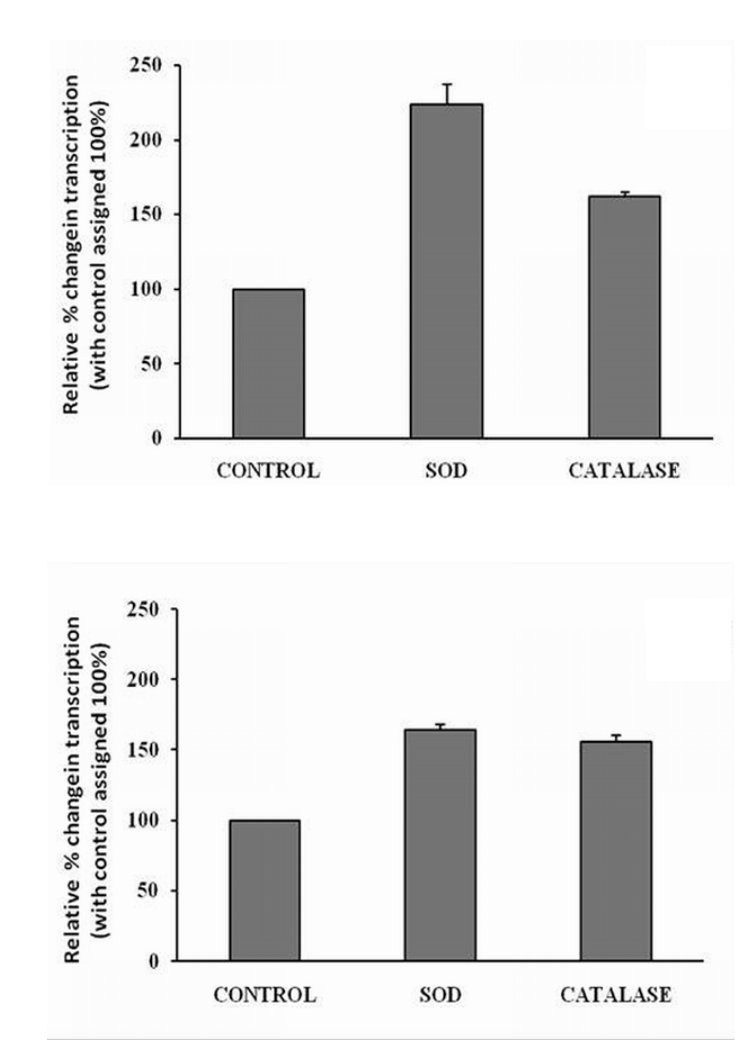
Figure 2 - Densitometry scanning of antioxidant enzymes following RT PCR program using scion image software in